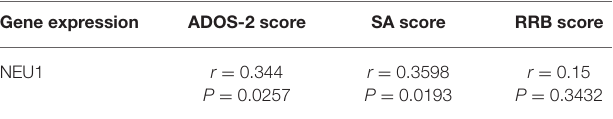
TABLE 4 | Correlation of NEU1 gene expression results to Autism Diagnostic Observation Schedule, Second Edition (ADOS-2), Social Affect (SA), and Restricted and Repetitive Behavior (RRB) in children with